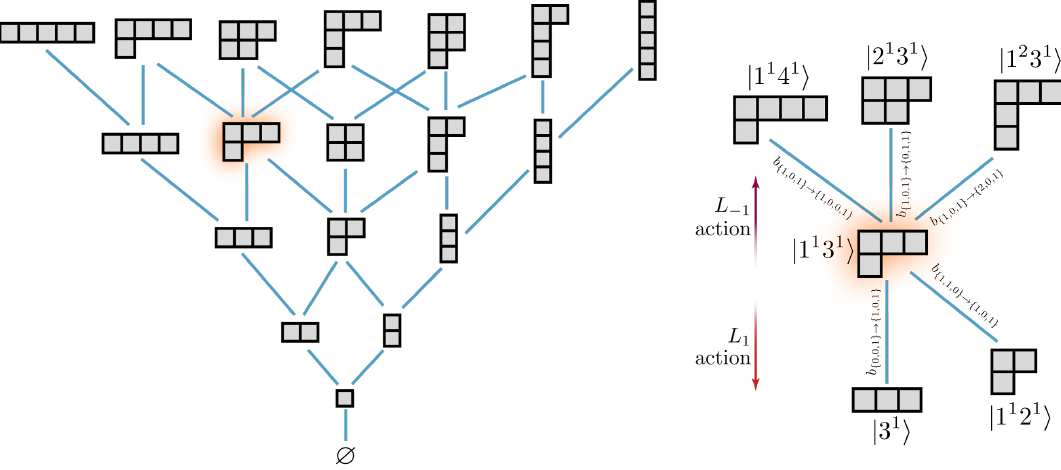
Figure 2 . [Left] The Young’s lattice denoting descendant states till level 5. [Right] Focusing on a specific vertex/descendant and its edges weighted by the Lanczos